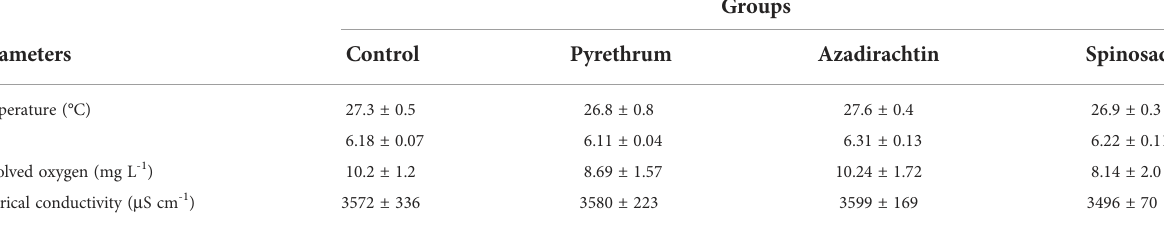
TABLE 1 The physico-chemical parameters (mean values ± SD) of the nutrient solutions during the raft and the media bed